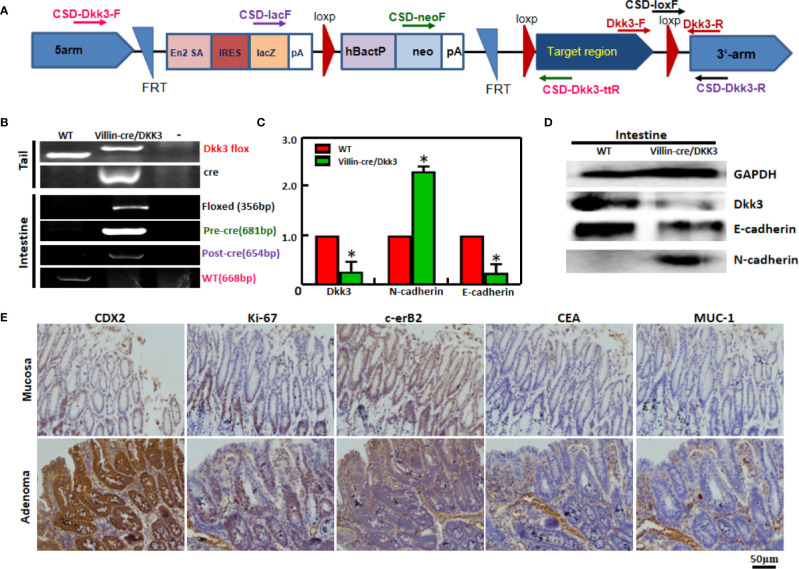
The effects of Dkk3 on tumor growth and carcinogenesis of colorectal cancer. PCR primers were designed (A) and subjected to PCR of tail and stomach DNA (B) with the same color for the corresponding primers and products. Expression of Dkk3, N-cadherin, and E-cadherin was confirmed by real-time PCR (C) and Western blot (D). Immunohistochemistry was employed to observe the maker proteins’ expression in the intestinal adenoma of target villin-cre/Dkk3 knockout mice induced by sodium desoxycholate (E). *p < 0.05, compared with the transfectant or knockout mice. WT, wild-type mice; VD, villin-cre +; Dkk3 -/-.